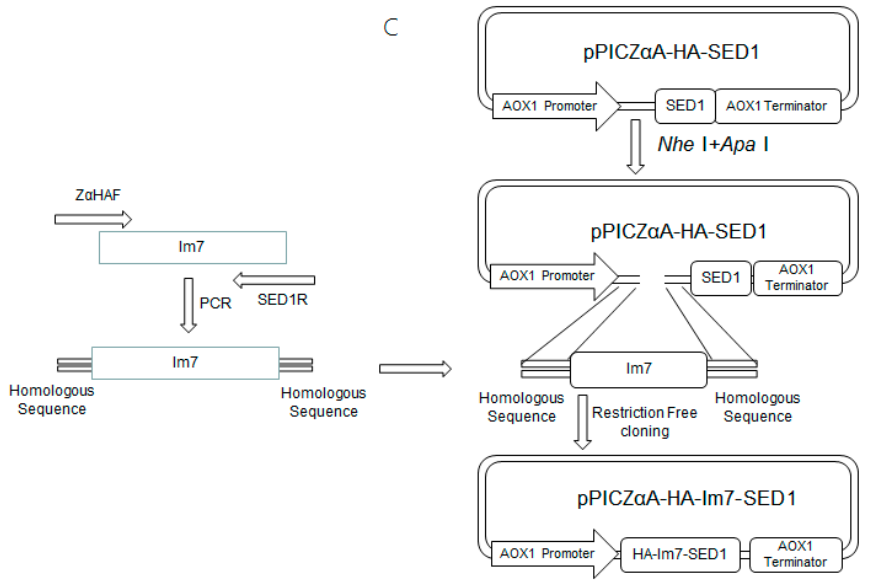
Figure 2. Schemes for the construction of plasmids including ( A ) pET23a ‐ CL7 ‐ sfGFP ( a ),